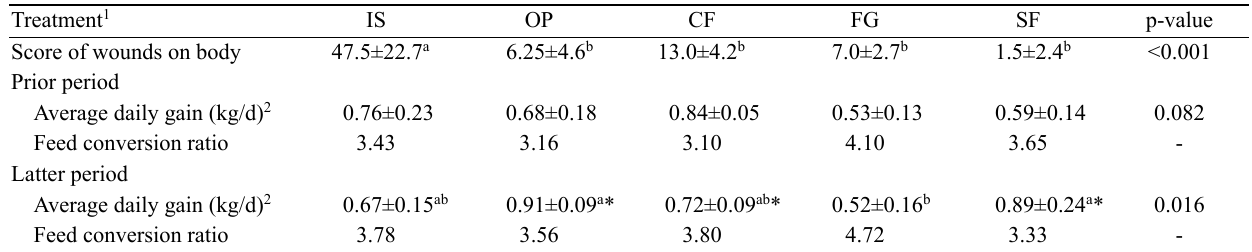
Table 5. The scores of wounds on the body using the Welfare Quality assessment protocol (2009) and performances of pigs in the five treatments Treatment